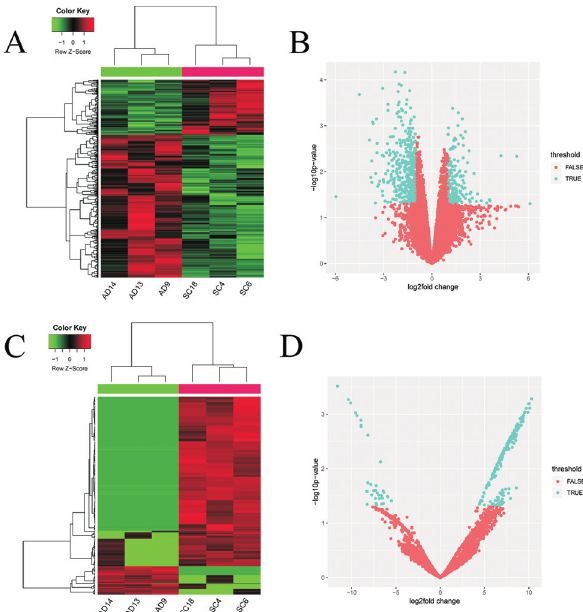
Figure 1 - Heatmaps and volcano plots of DEmiRNAs differentially ex- pressed mRNAs and DEcircRNA, miRNAs and lncRNAs. (A) heatmap for DEmRNAs, (B) volcano plot for DEmRNAs, (C) heatmap for DEcircRNA, and (D) heatmap for DEcircRNA. DEmRNAs: differentially expressed mRNAs; DEcircRNA: differentially expressed